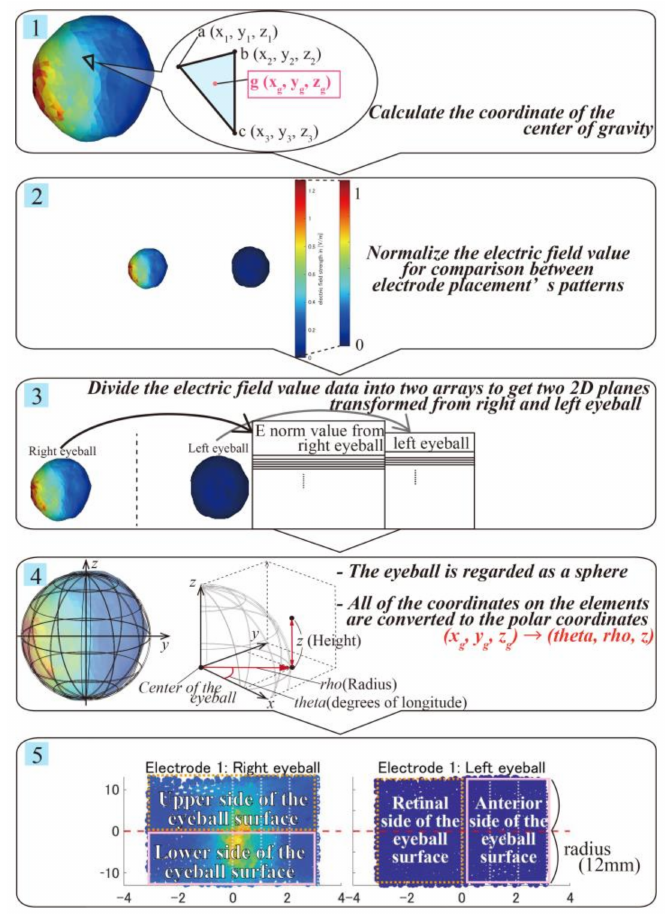
Figure 6. Method for transforming eyeballs into two planes for